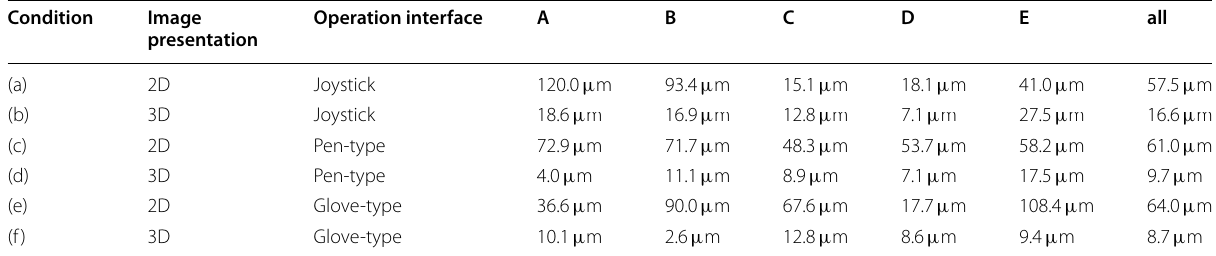
Table 4 Mean error Condition Image presentation